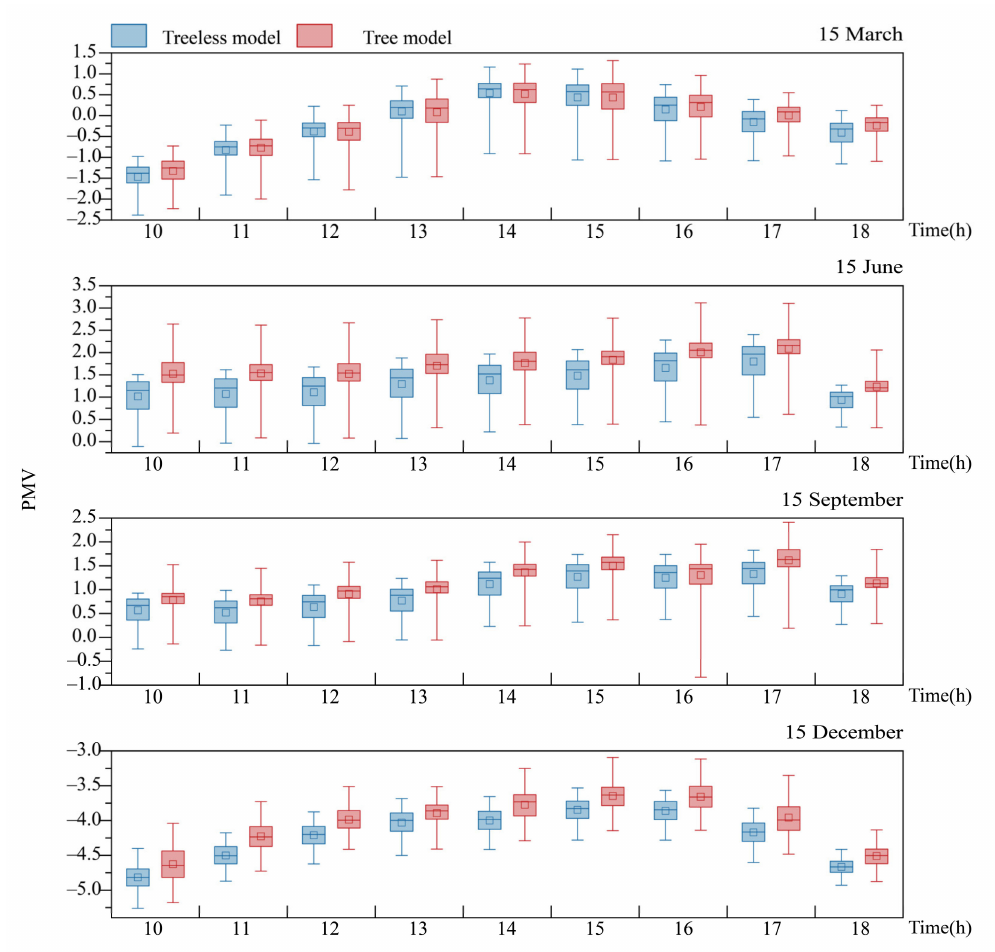
Figure 10. Comparison of the range of PMV between two models at a height of 1.2 m on four